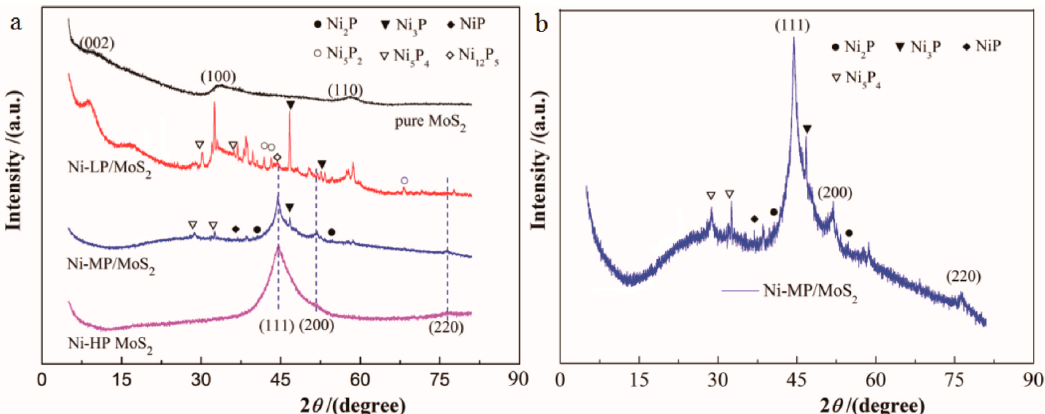
Figure 1. X-ray diffraction (XRD) spectra of the pure MoS 2 and three Ni–P/MoS 2 composites: ( a )